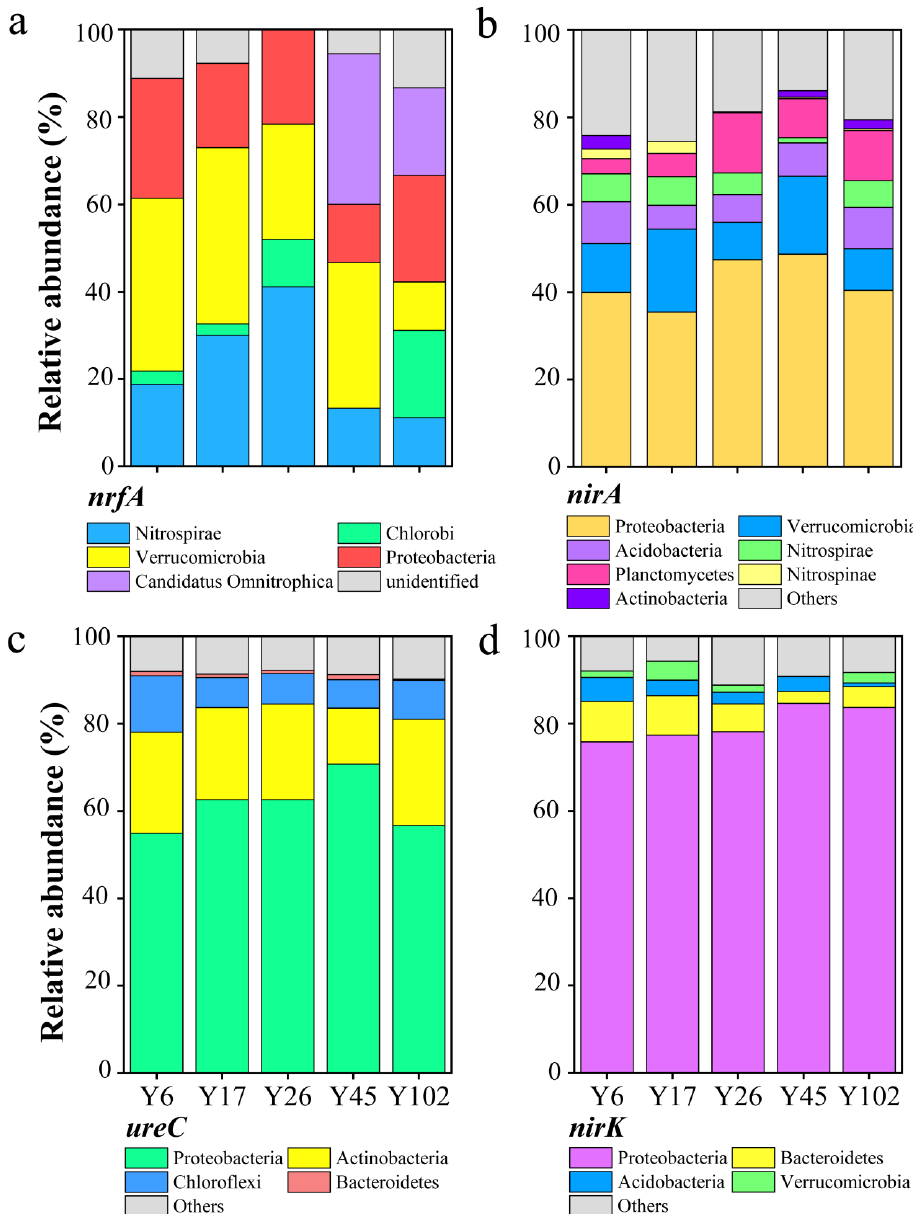
Figure 5. Phyla containing genes involved in N cycling processes in Chinese fir stand ages in subtropical China. ( a ) nrfA; ( b ) nirA; ( c ) ureC; ( d )